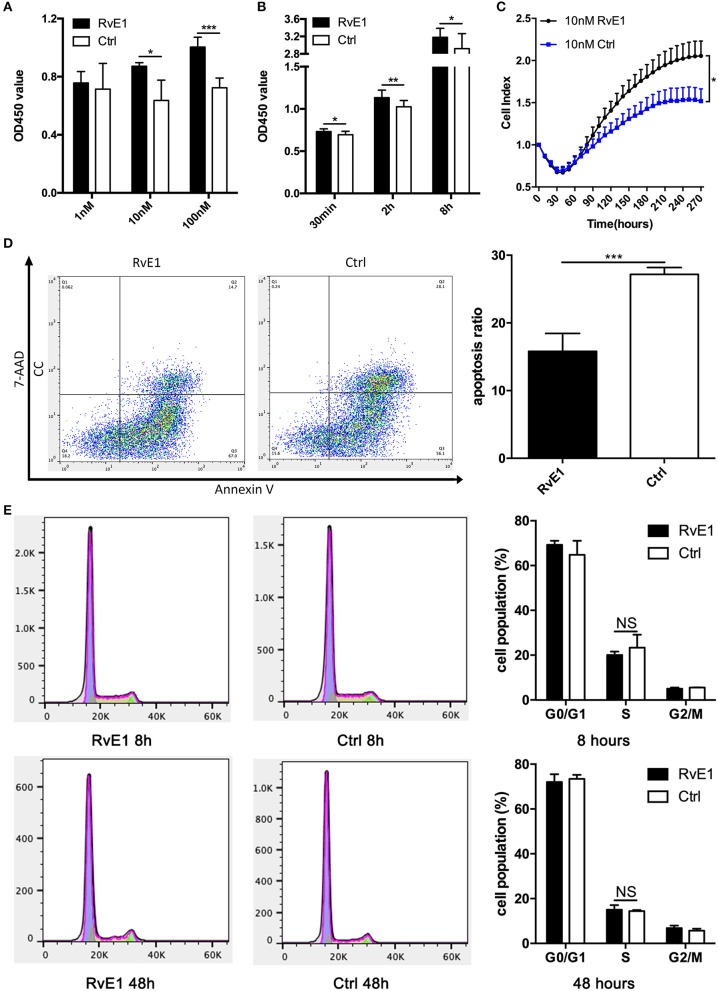
The effects of RvE1 on cumulus cells (CCs). (A,B) CCs' viability was measured by CCK-8 after treatment with 1, 10, and 100 nM RvE1 for 30 min (A) and 10 nM RvE1 for 0.5, 2, and 8 h (B). Equal amounts of RvE1 solvent, anhydrous ethanol, as a negative control. Data are presented as mean ± SD; *p < 0.05; **p < 0.01; ***p < 0.001, multiple unpaired t-test with two tails using Holm-Sidak correction, three (A) and twelve (B) independent biological replicates. (C) Cell proliferation of 10 nM RvE1 treated CCs was detected by Label-free Real-time Cellular Analysis (RTCA). Equal amounts of anhydrous ethanol as negative control. Data are presented as mean ± SEM; *p < 0.05, multiple unpaired t-tests with two tails using Holm-Sidak correction, eight independent biological replicates. (D) Apoptosis of CCs treated with 10 nM RvE1 for 8 h. Equal amounts of anhydrous ethanol as a negative control. Data are presented as mean ± SD; ***p < 0.001; t-tests with two tails, five independent biological replicates. (E) The cell cycle of CCs with a treatment of 10 nM RvE1 for 8 and 48 h. Equal amounts of anhydrous ethanol as a negative control. Data are presented as mean ± SD; NS, p > 0.05, t-test with two tails, three independent biological replicates.